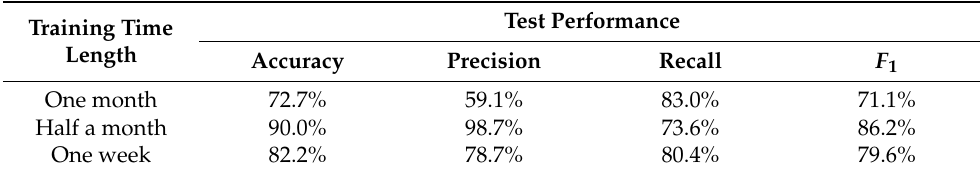
Table 7. Prediction results after different training time